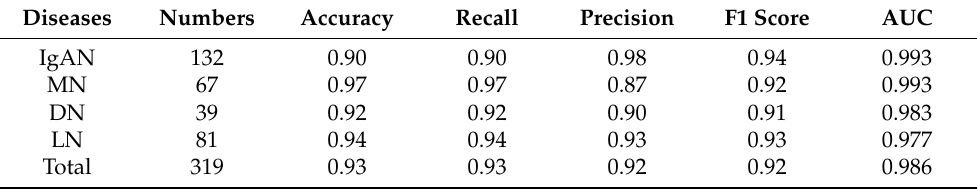
Table 3. Common MTL method performance in disease diagnosis based on blurred IF images.